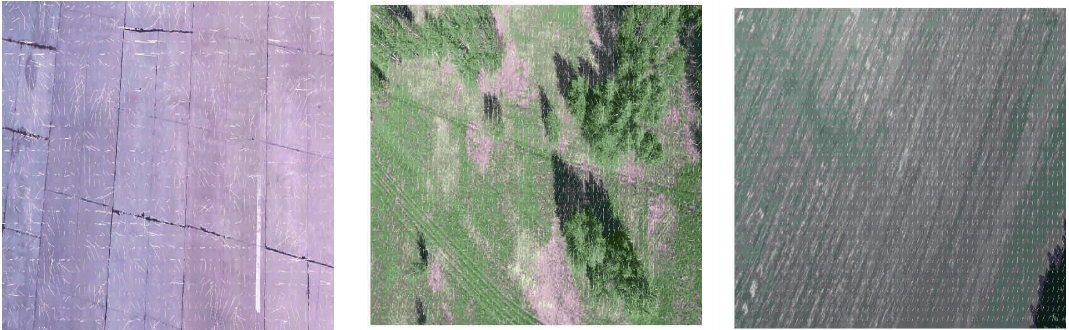
Figure 4. Optical flow estimated at landing with averaging 8 × 8 at the altitudes 195 m ( right ), 50 m ( centre ), and 20 m ( left